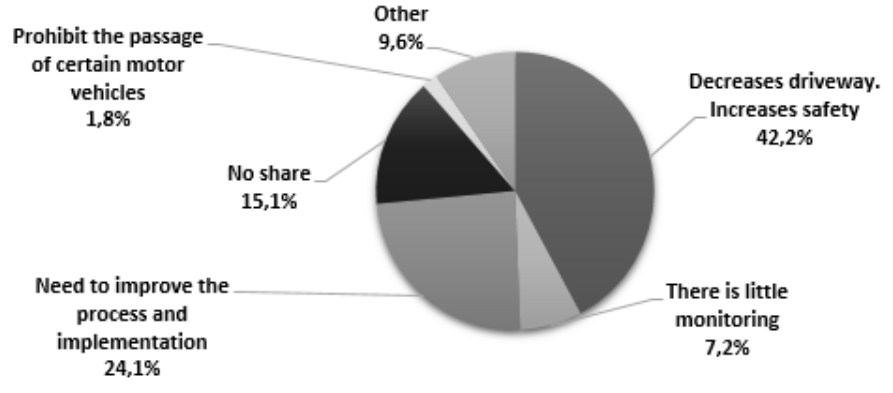
Figure 2. Interviewees’ opinions about the forest regulations.